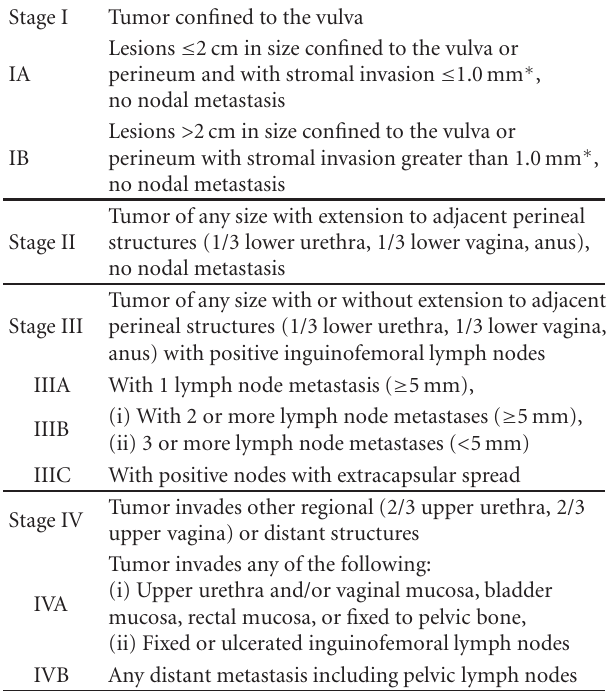
Table 1: FIGO staging of invasive cancer of the vulva.